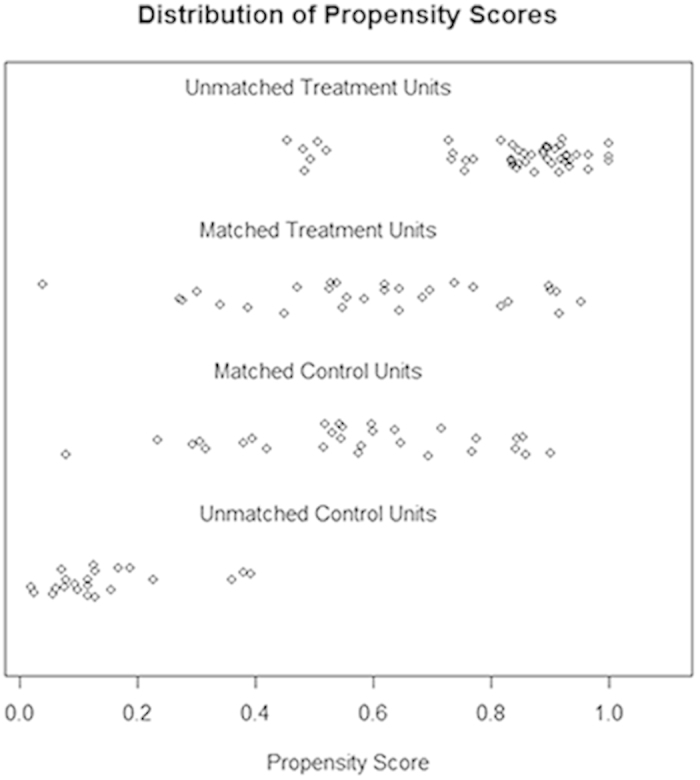
Dot plot of the propensity scores of patients with benign and malignant fGGOs showing individual units in the dataset and whether they were matched or discarded.Treatment units: patients with malignant fGGOs; Control units: patients with benign fGGOs.